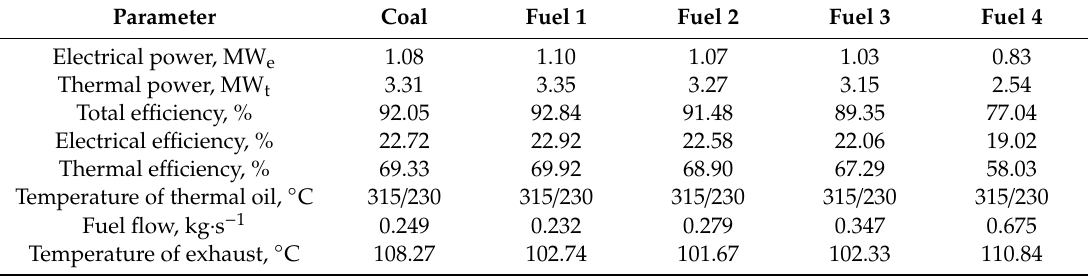
Table 4. The energetic parameters obtained with the use of the authorial system ORC with regeneration.